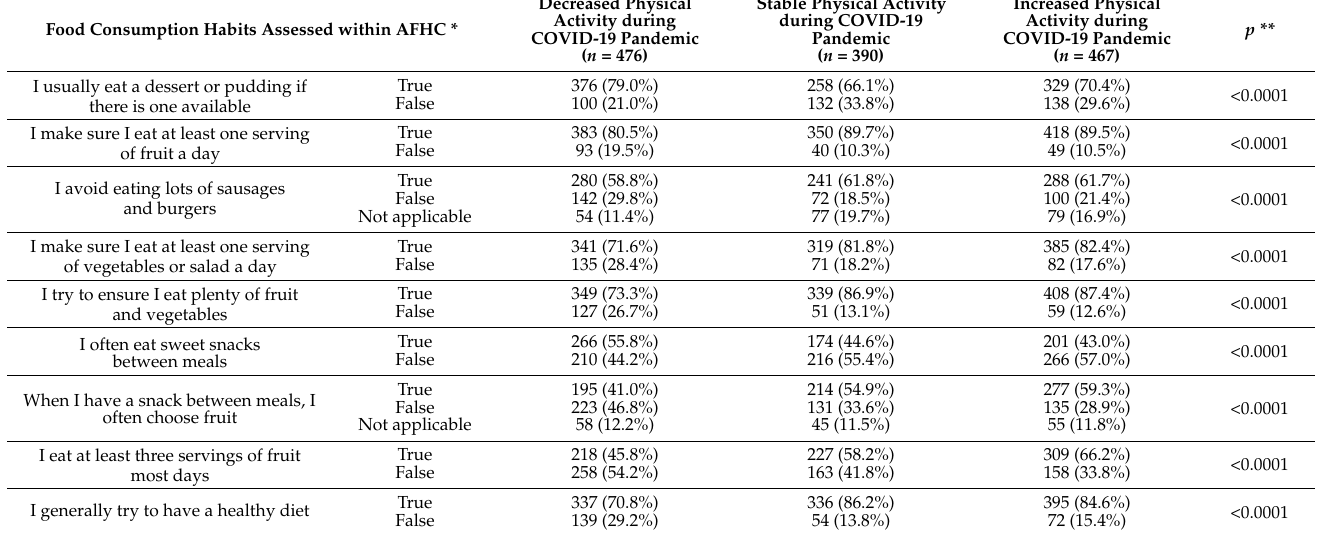
Table 9. The food consumption habits assessed while using Adolescents’ Food Habits Checklist (AFHC) in the period during the COVID-19 pandemic, as declared by the adolescents from the Diet and Activity of Youth during COVID-19 (DAY-19) Study cohort ( n = 1333) in sub-groups of adolescents declaring decreased, stable, and increased physical activity during the COVID-19